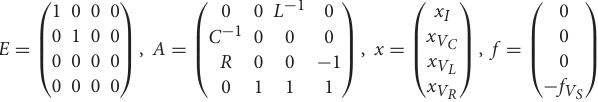
Algorithm 1 | (Weak) Greedy method